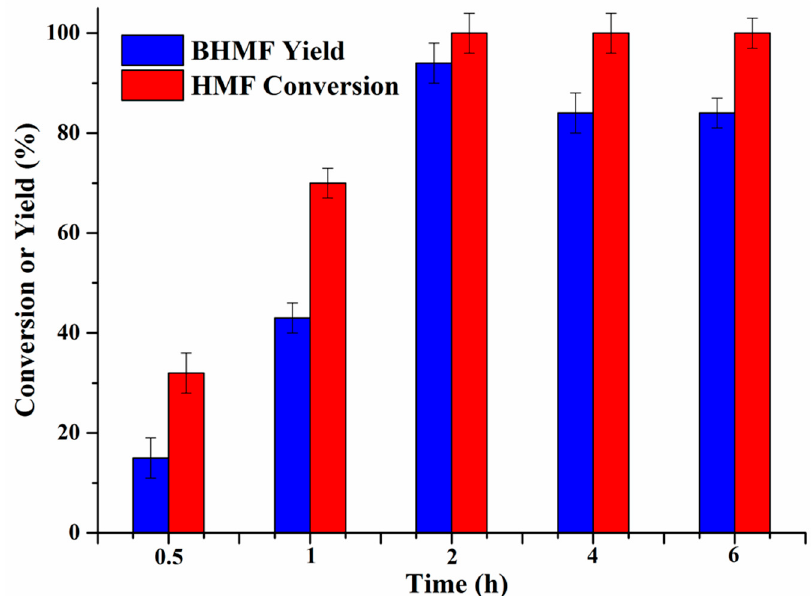
Figure 2. The effect of reaction time on the reduction of HMF into BHMF. (Reaction conditions: HMF (0.5 mmol), K 2 CO 3 (0.1 mmol), Ph 2 SiH 2 (1.4 mmol H − ), MTHF (2 mL), and 25 °C; After the reaction, 3